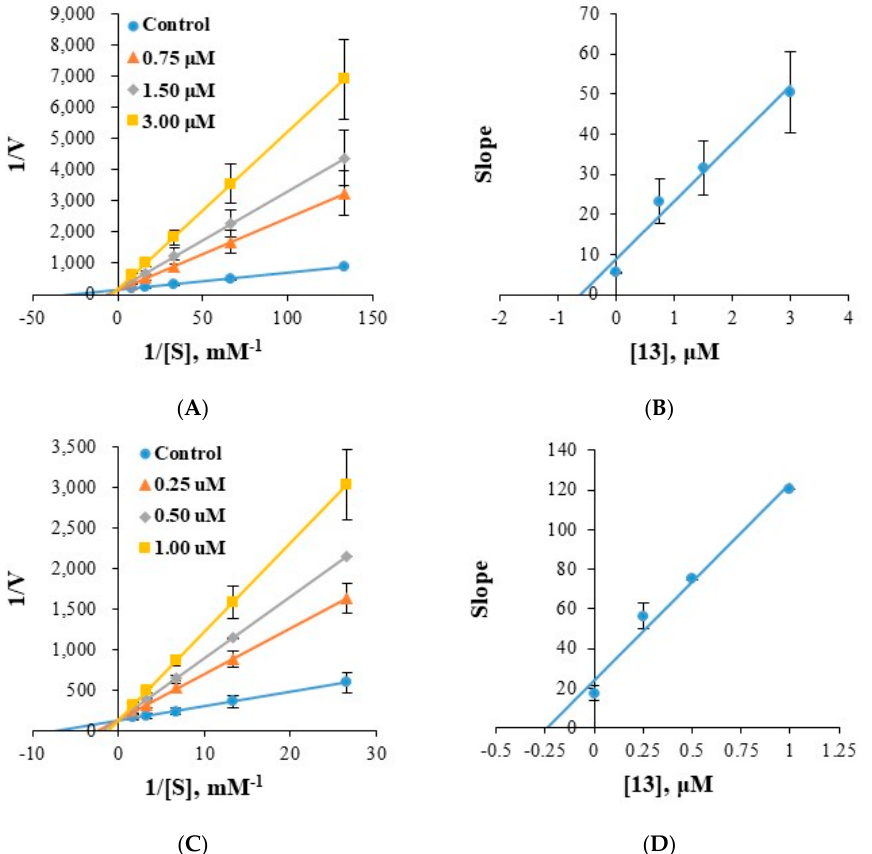
Figure 6. Lineweaver-Burk plots of hMAO-A and hMAO-B inhibitions by 13 ( A and C , respectively) and their respective secondary plots ( B , D ) of slopes of Lineweaver-Burk plots versus inhibitor concentrations. Substrate hMAO-A and hMAO-B concentrations ranged from 0.0075 to 0.12, 0.03 to 0.6 mM, respectively. Experiments were carried out at three inhibitor concentrations, that is, ~0.5, 1.0, and 2.0 times IC 50 values. Initial velocity was expressed as an increase in absorbance per min.